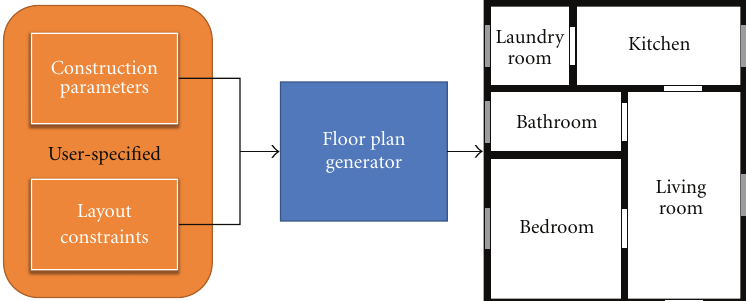
Figure 5: The generation process of floor plans. Construction parameters and layout constraints are provided by the user as input to floor plan generator.